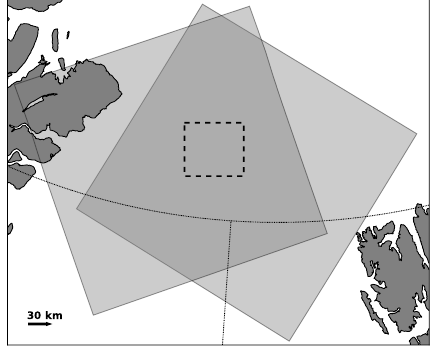
Figure 1. Coverage of image pair Fram Strait that is used as repre- sentative image pair to explain the algorithm approach. The dashed rectangle depicts the area shown in Fig. 4 and illustrates the vector distribution of the algorithm